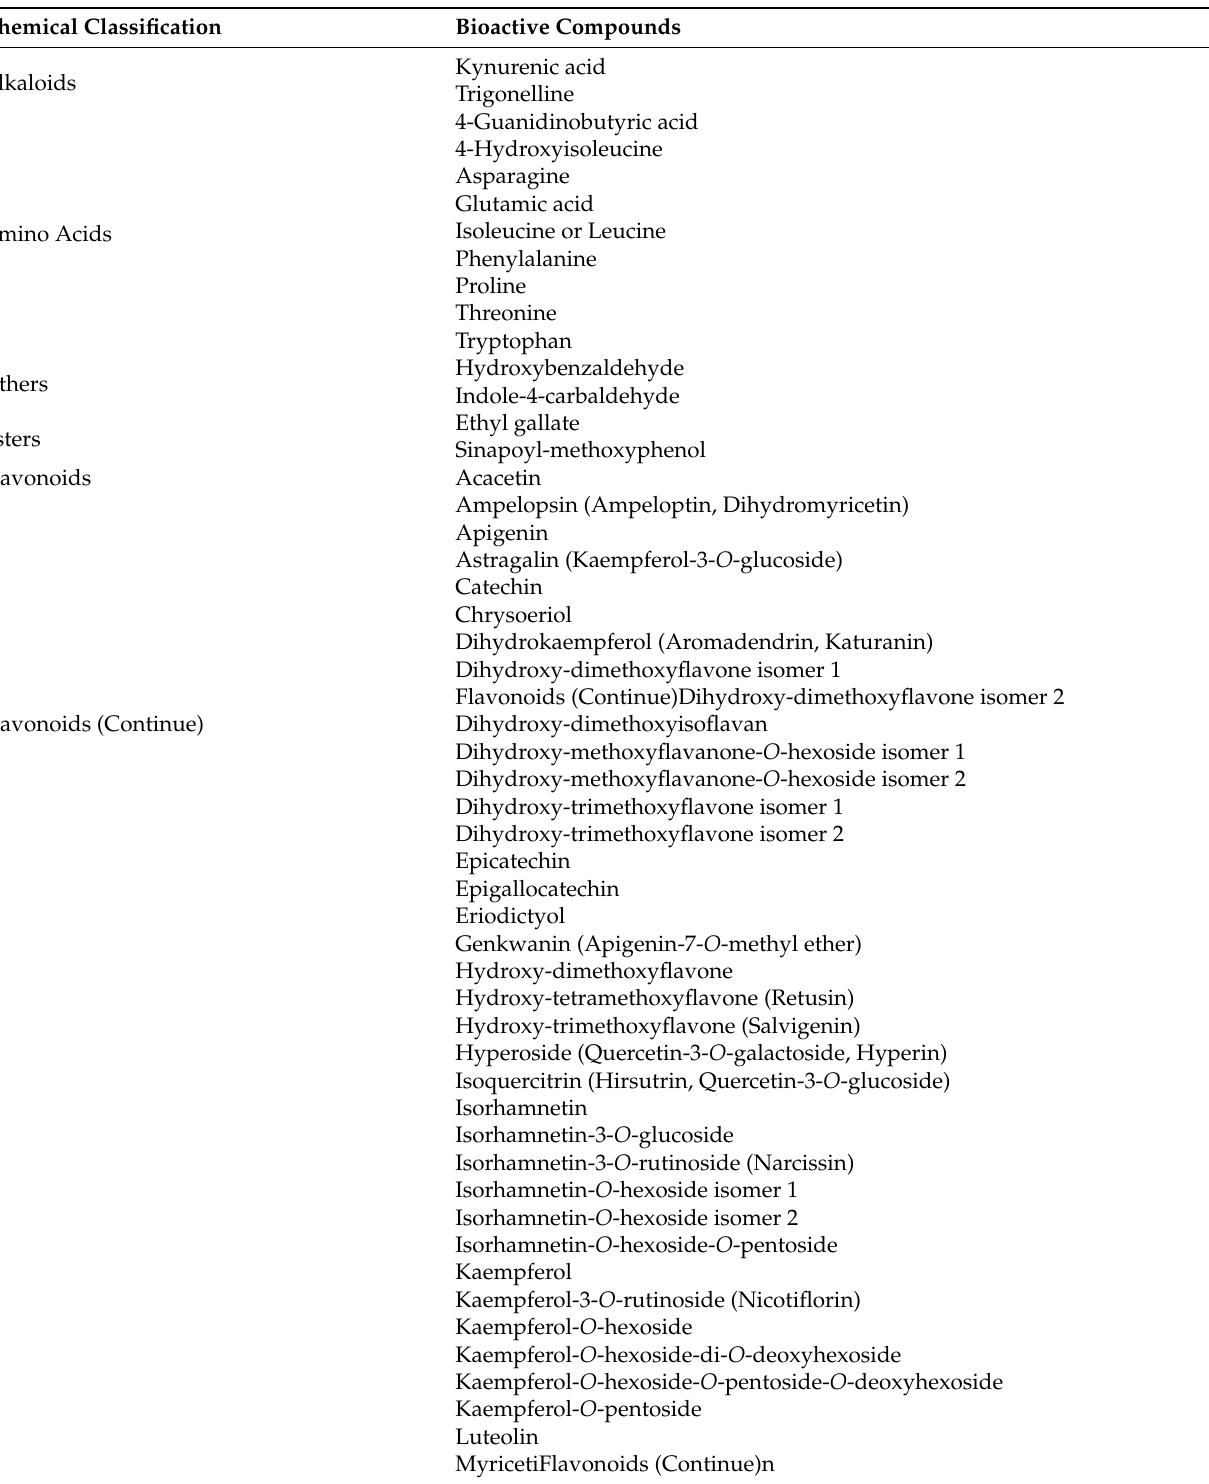
Table 1. The phytonutrient profile of